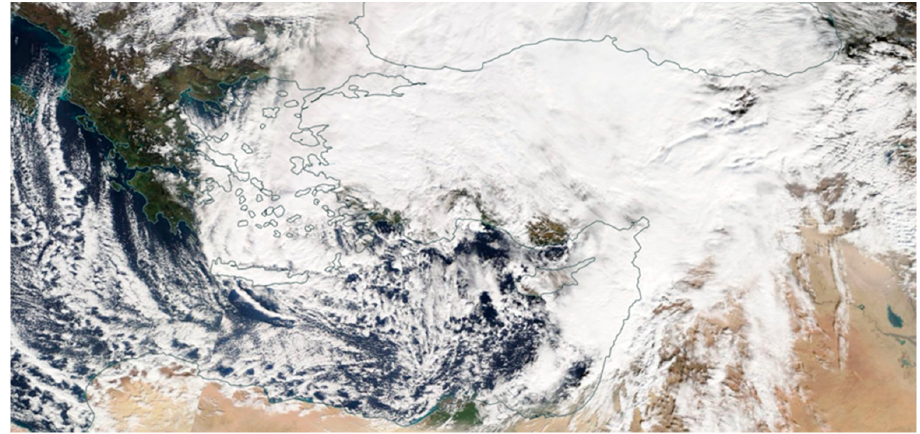
Figure 6. The explosive cyclone, on 11 December 2010—Terra/Modis imagery, taken from: https://worldview.earthdata.nasa.gov, (accessed 27 April 2021) (NASA Worldview, EOSDIS). 986.5 hPa between 10 December 2010 18 UTC and 11 December 2010 03 UTC, initially as